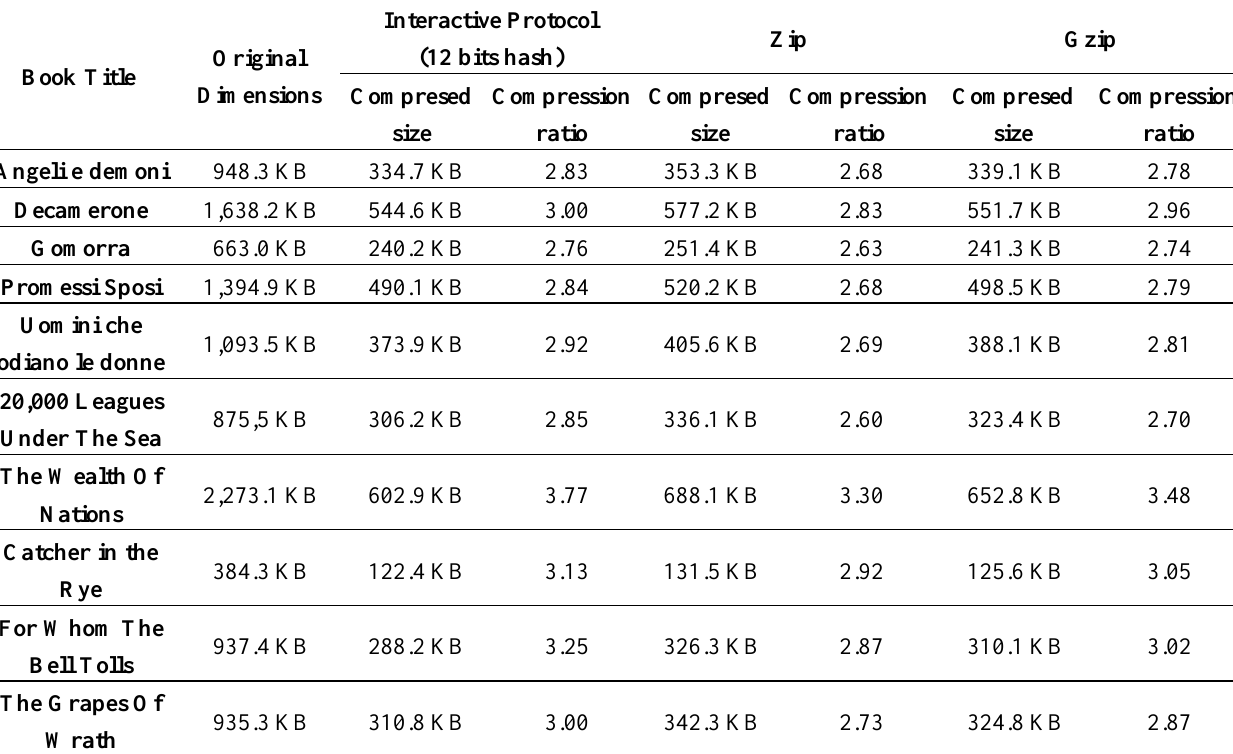
Table 1. Compression results.